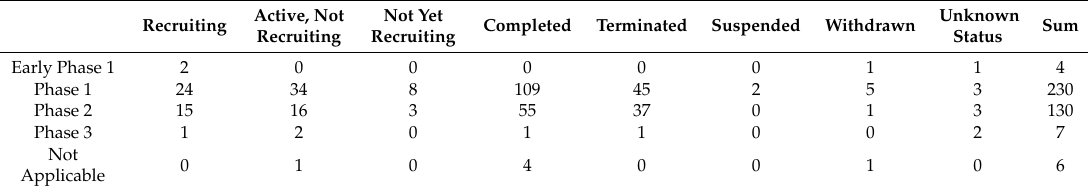
Table 2. Phase and status of HDACi clinical trials: clinical trials registered in https: // clinicaltrials.gov / in solid tumors with